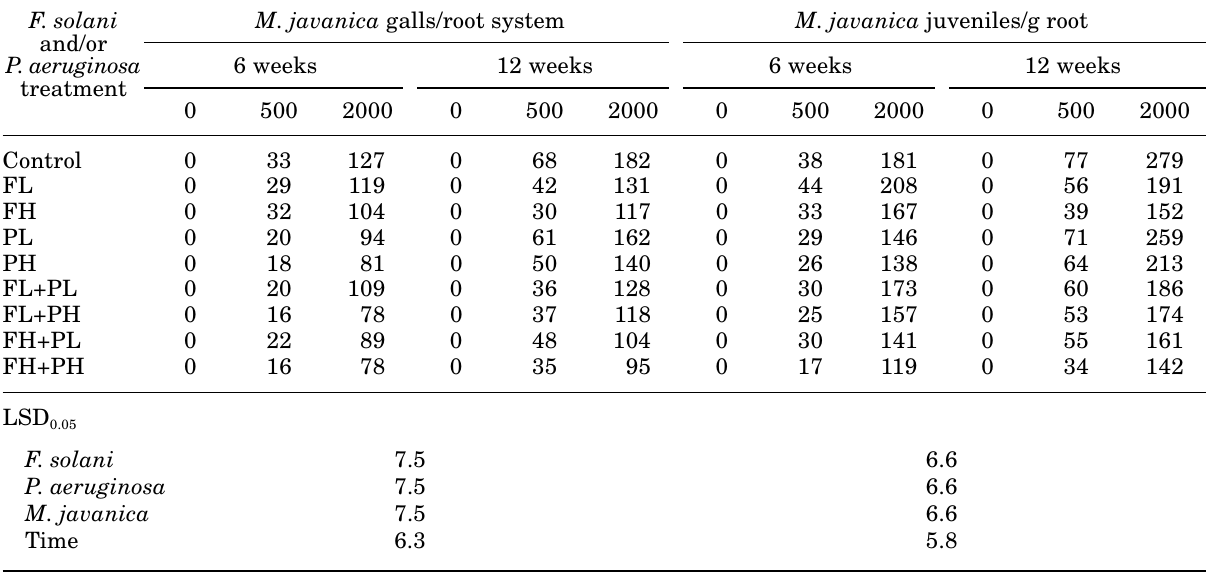
Table 2. Number of galls per root system and number of juveniles g -1 of root extracted from tomato roots harvested 6 and 12 weeks after inoculation with 0, 500 or 2000 Meloidogyne javanica juveniles per pot and treated with Fusarium solani at rates of 10 6 (FL) or 10 7 (FH) cfu ml -1 suspension, or with Pseudomonas aeruginosa at rates of 10 7 (PL) or 10